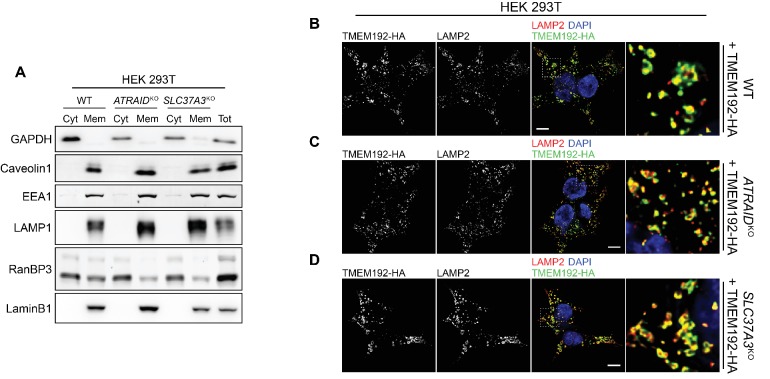
Quality controls for the radioactive uptake assays.(A) Immunoblot against markers for cytosol (GAPDH), plasma membrane (Caveolin1), early endosome (EEA1), lysosome (LAMP1), nucleosol (RaN-BP3), and nucleoskeleton (LaminB1) in cytosolic fractions and membranous fractions in wild-type, ATRAIDKO and SLC37A3KO HEK 293 T cells, demonstrating successful subcellular fractionation in the fractionation-based radioactive uptake assay. Cyt: cytosolic fraction. Mem: membranous fraction. Tot: total cell lysate. (B–D) Localization of HA tagged TMEM192 (TMEM192-HA), a lysosomal protein we expressed in wild-type (B), ATRAIDKO (C) and SLC37A3KO (D) HEK 293 T cells and used as a handle to immuno-precipitate lysosomes, shown with a lysosomal marker, LAMP2, demonstrating correct localization of TMEM192-HA to lysosomes and, consequently, successful purification of lysosomes in the lysosome-purification-based uptake assay. Scale bars represent 10 µm. Each image displayed is the representative example chosen from at least five similar images.